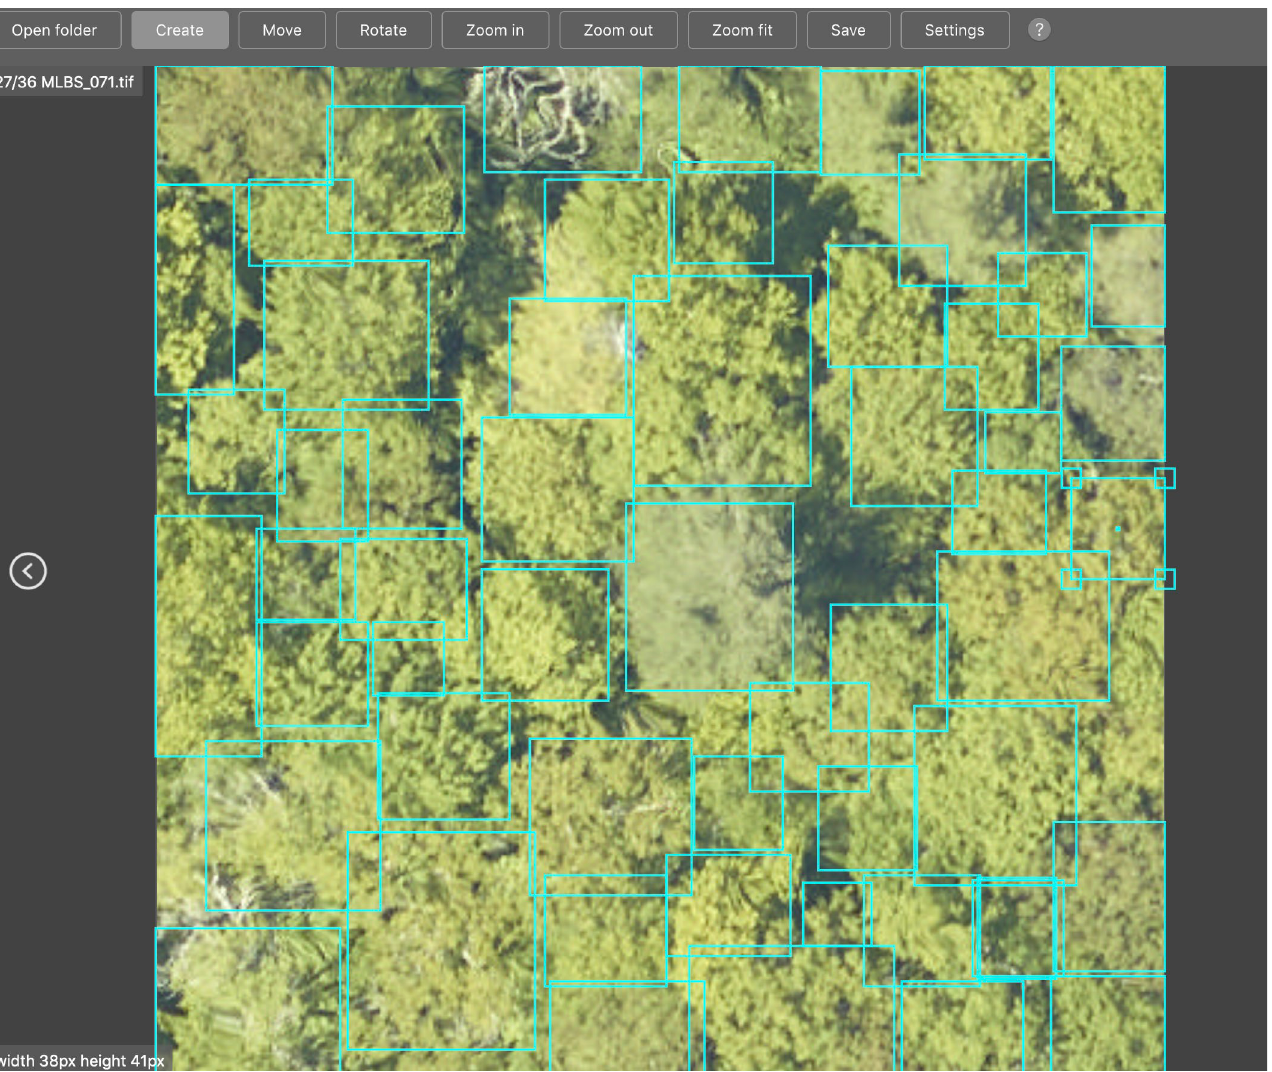
Fig 4. Screenshot of the program RectLabel used for tree annotation for the image-annotated crowns for NEON plot MLBS_071. For each visible tree crown, we created a four point bounding box.